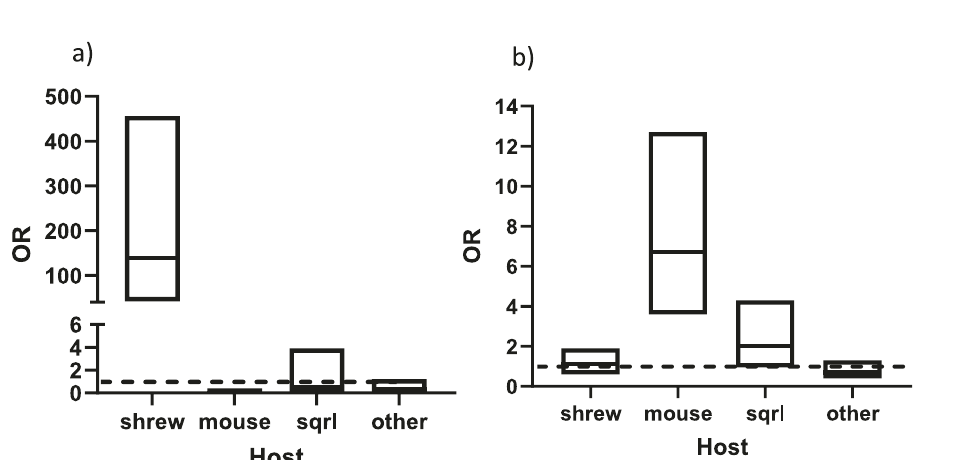
Fig. 4 The likelihood that an infected tick had fed on either a shrew, mouse, squirrel (or other Sciuridae ), or other host. The data for deer tick virus- infected ticks are shown in panel a , and the data for B. burgdorferi -infected ticks are shown in panel b . Data are represented by boxplots of odds ratios (OR) with 95% con fi dence intervals, and all fi eld sites are combined ( n = 20 deer tick virus-infected ticks, n = 128 B. burgdorferi -infected ticks). A line is drawn at OR = 1, and any con fi dence interval that crosses it is not statistically signi fi cant. Sqrl = squirrel (or other Sciuridae